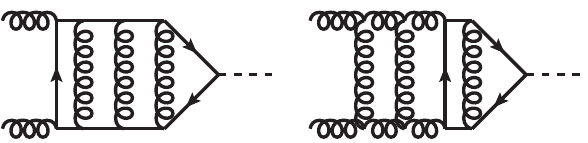
Figure 5: Virtual corrections contributing to g g → H at